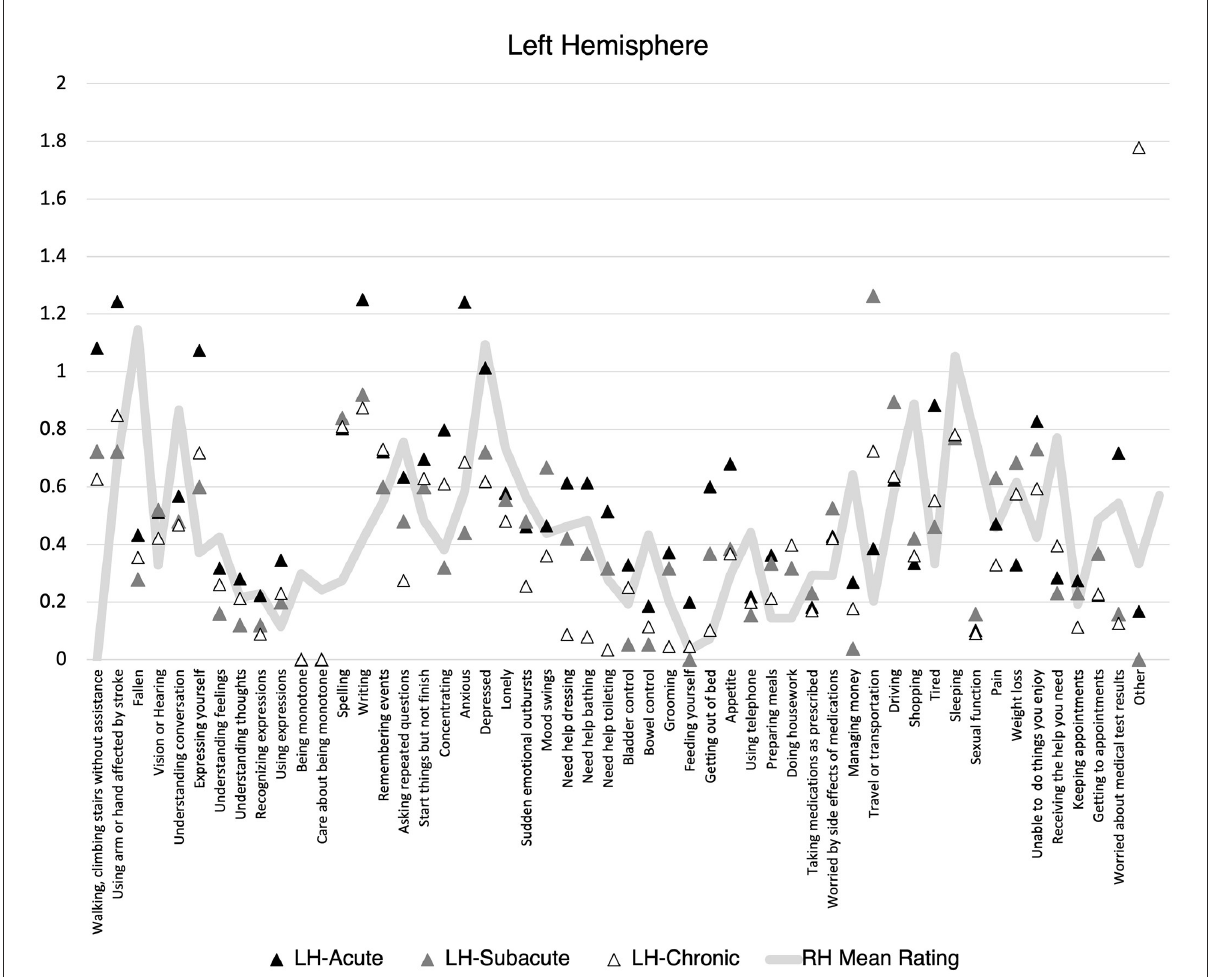
FIGURE1 Mean Stroke Patient Questionnaire (SPQ) item rating (0-2) by recovery time point for individuals with left hemisphere stroke. Mean right hemisphere rating included for